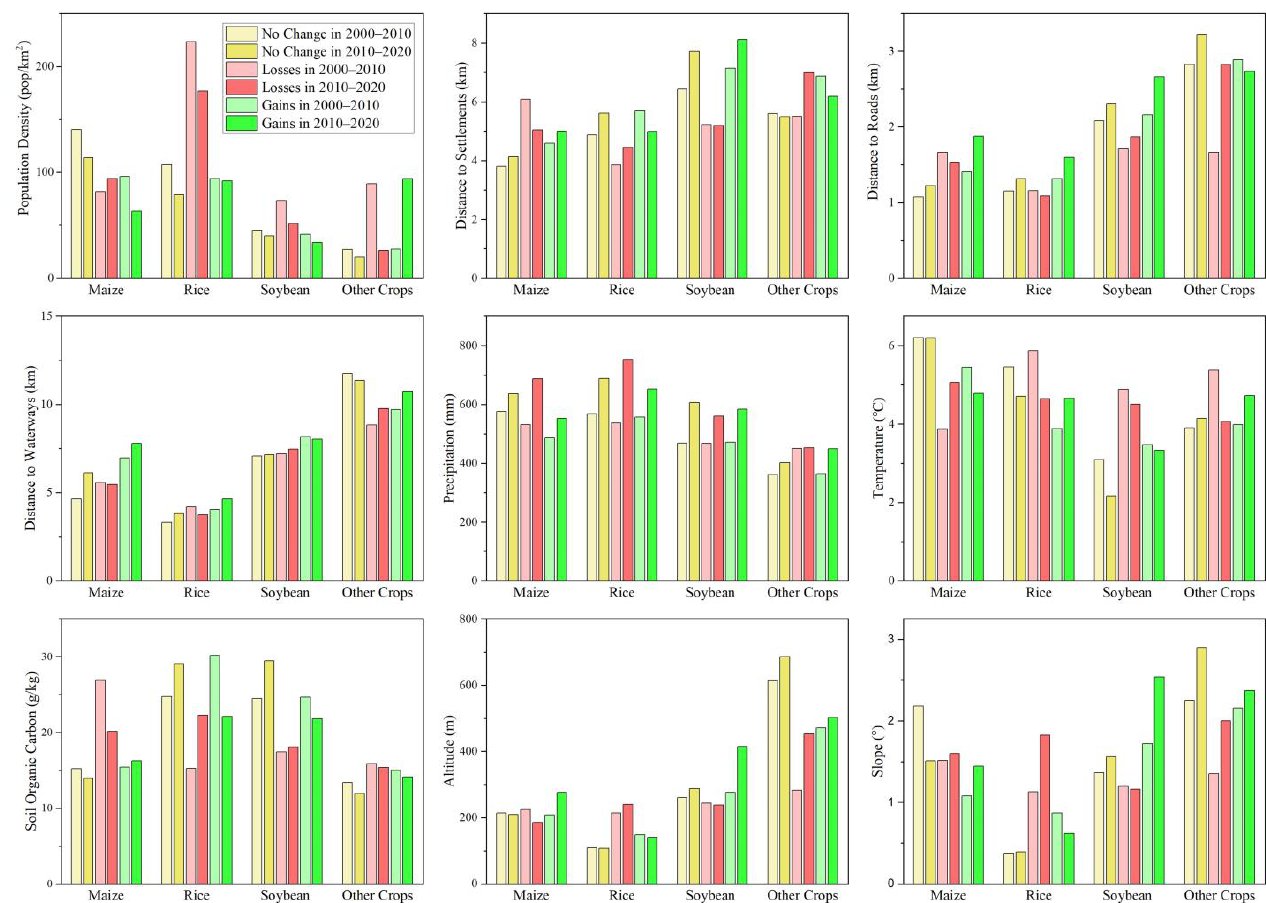
Figure 9. Anthropogenic and natural characteristics of crop type changes in the NEC during 2000 –